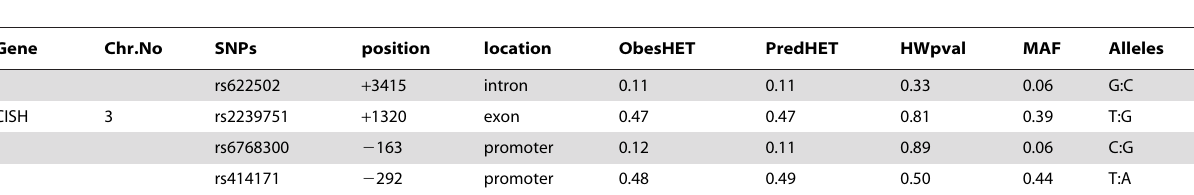
Table 2. SNP marker information for CISH gene for all subjects studied (persistent HBV infection and HBV-resolved).